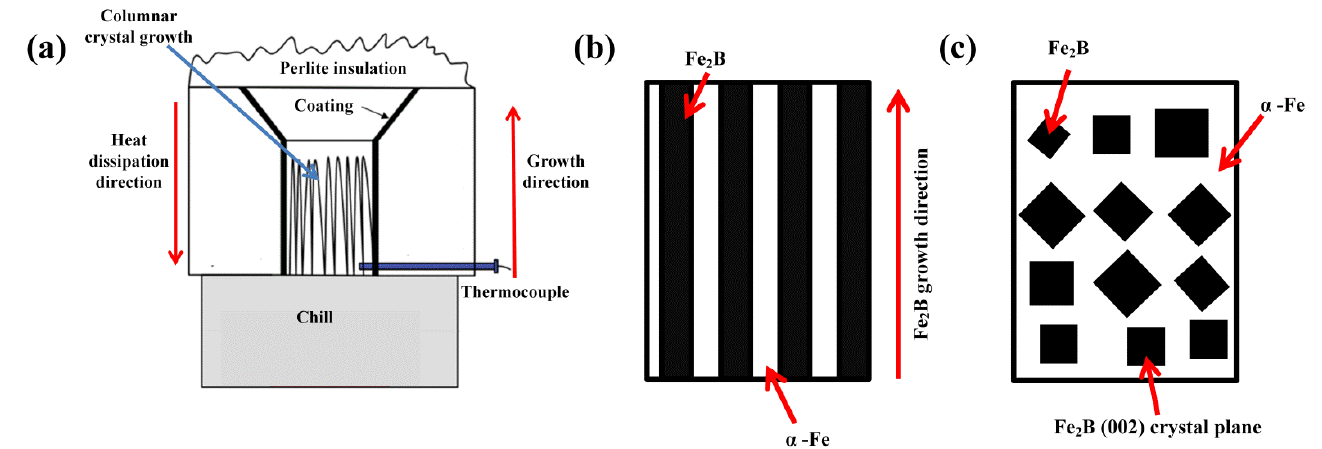
Figure 1. The schematic maps of directional solidification device and orientation plane of DS Fe-B alloy: ( a ) schematic device of DS (directionally solidified) cast Fe-B alloy (solidification rate of about 15 °C/s measured by a thermocouple), ( b ) the schematical morphology of the longitudinal section in DS Fe-B alloy, ( c ) the schematical morphology of the transverse section in DS Fe-B alloy. Table 1. Chemical compositions of cast DS Fe-B alloy by spark emission spectrometer (wt.%). Samples